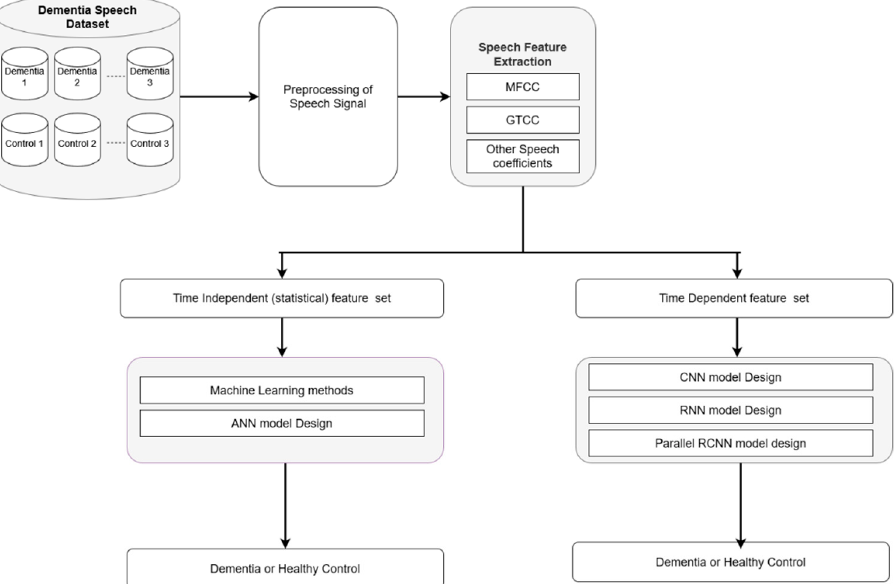
Figure 1. Flow diagram of proposed dementia detection methodology through ML and DL models.